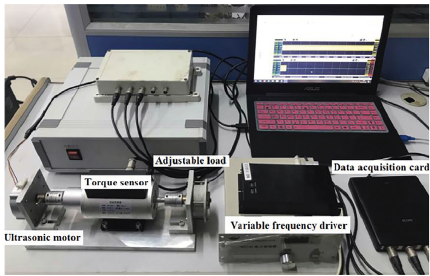
Figure 2: Testbed for the ultrasonic motor.